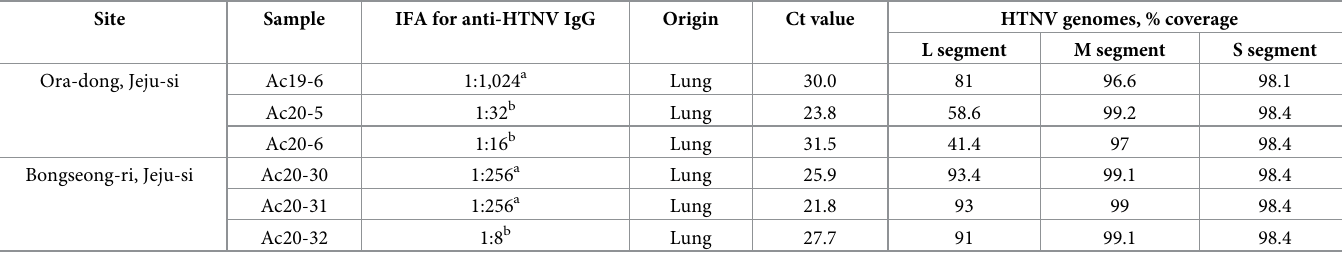
Table 3. Next-generation sequencing coverages of Hantaan virus (HTNV) from rodents collected in Jeju Island, 2018–2020.